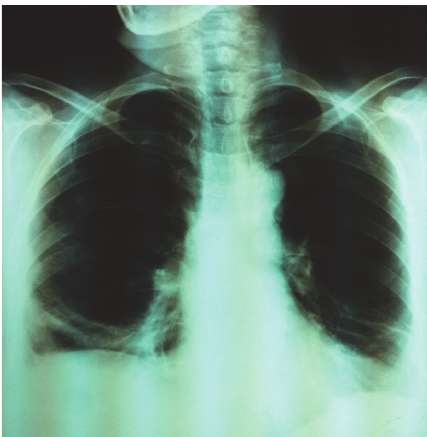
Figure 5: X-ray chest after surgery